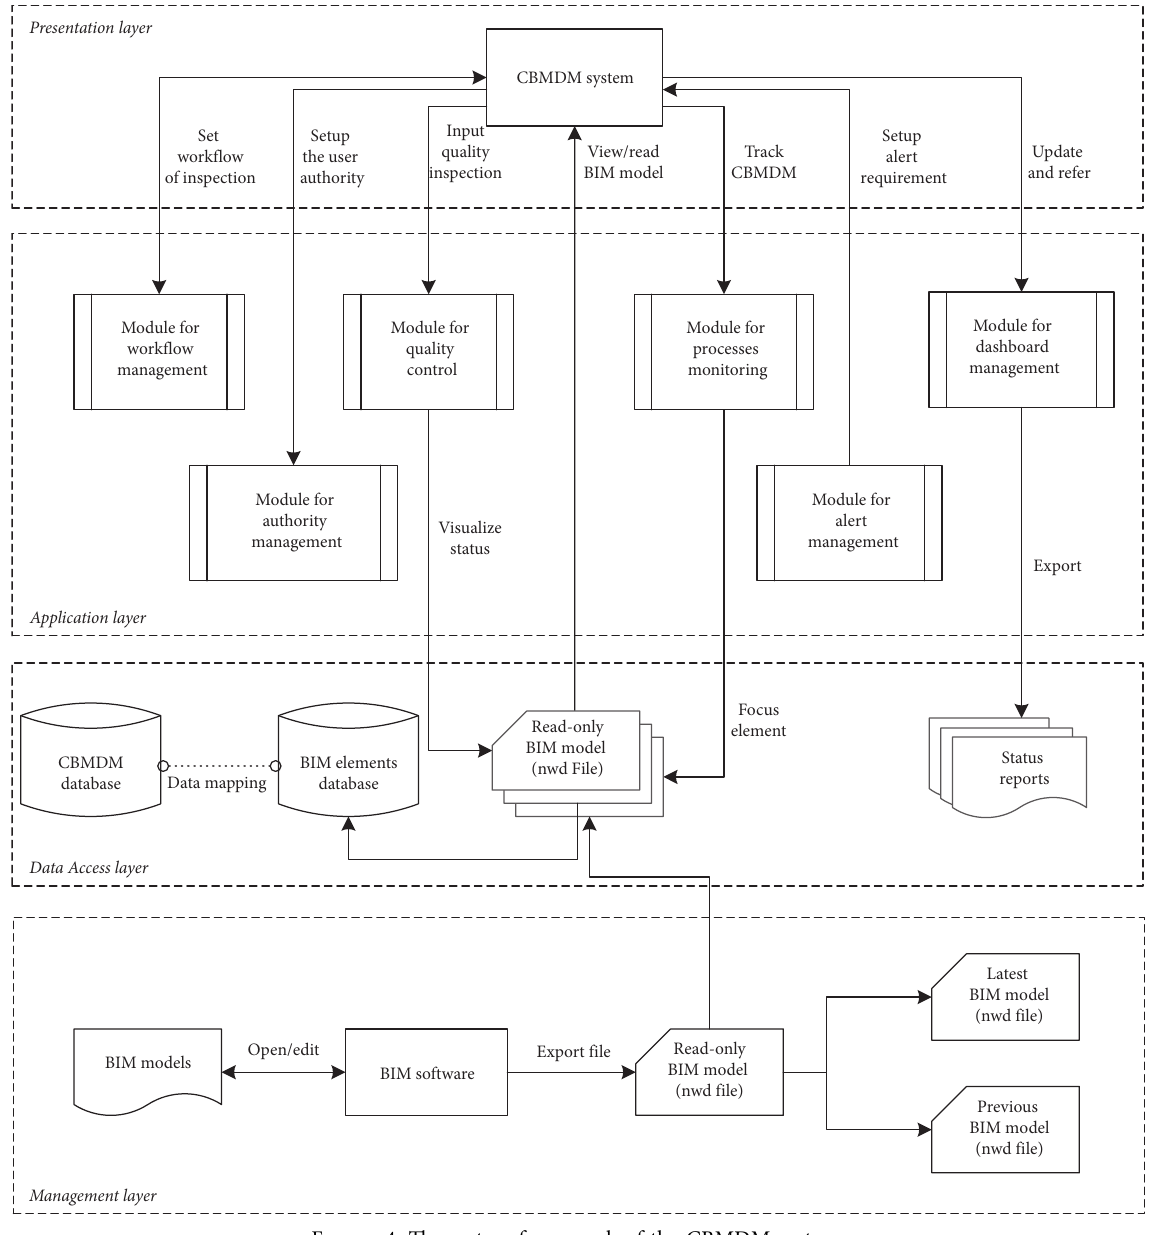
Figure 4: The system framework of the CBMDM